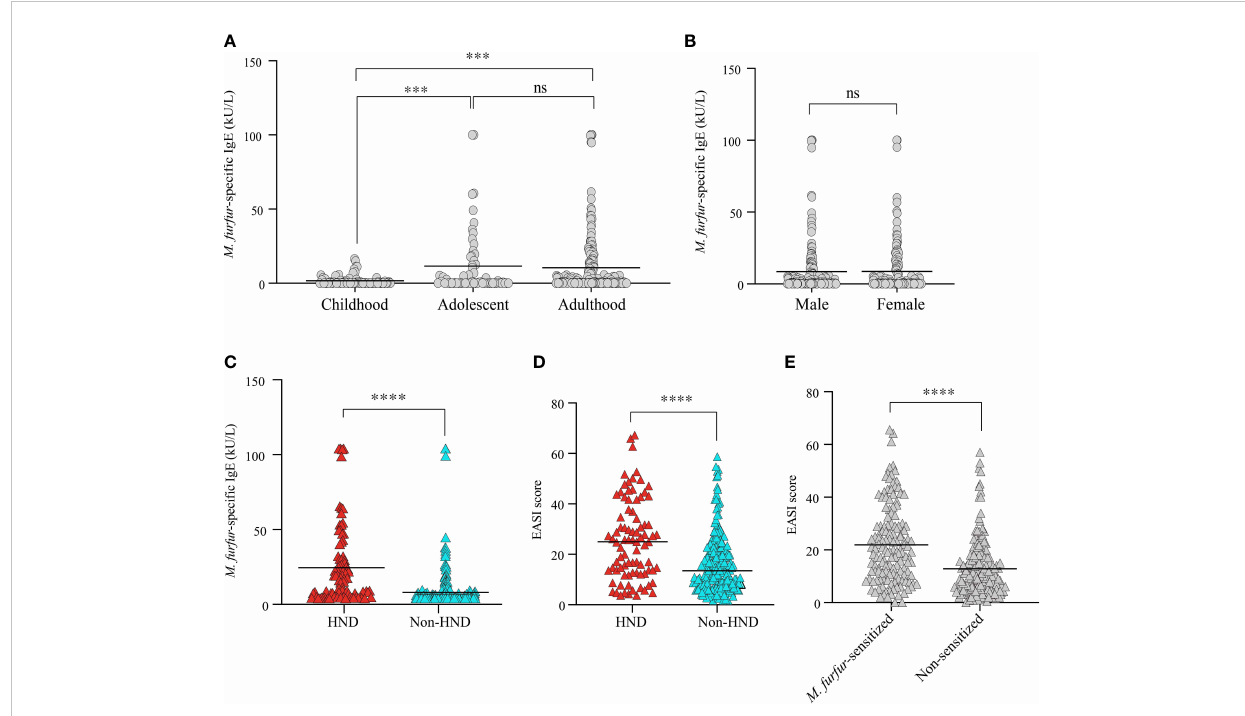
FIGURE 1 Comparison of serum M. furfur -speci fi c IgE level according to (A) age groups, (B) sex, and (C) the presence of HND. Clinical severity according to (D) the presence of HND, (E) M. furfur sensitization status. (Unpaired t-test, (A) Childhood vs. Adolescent; p = 0.0002, Adulthood vs. Adolescent; p = 0.7392, Adulthood vs. Childhood; p = 0.0003, (B) p = 0.9634, (C) p< 0.0001 (D) p< 0.0001 (E) p< 0.0001) HND, Head and neck dermatitis. *** : p<0.001; **** : p<0.0001; ns, Not Signi fi cant (p